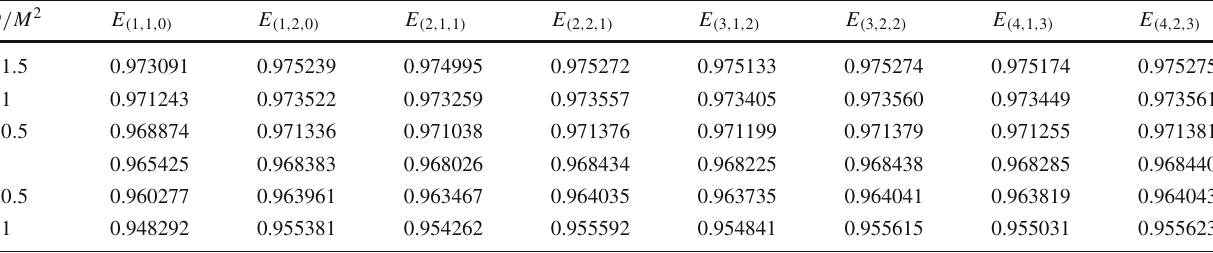
Table 1 The energy E ( z ,w,ν) for periodic orbits ( z ,w,ν) [ q = w + ν/ z ] around the DMPR brane-world black holes for different values of Q with (cid:14) = 0 .